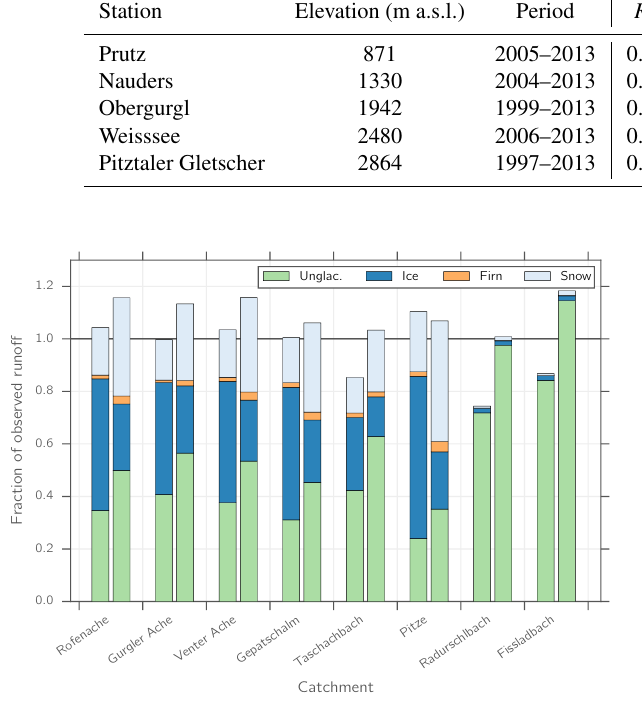
Figure 16. Runoff components (prior to the diversion into the soil reservoir) as simulated by AMUNDSEN for the calibration period 1998–2006 shown as fractions of the mean observed runoff in the same period. The two bars for each catchment show the results for the model runs using uncorrected (left) and corrected (right) precip- itation,